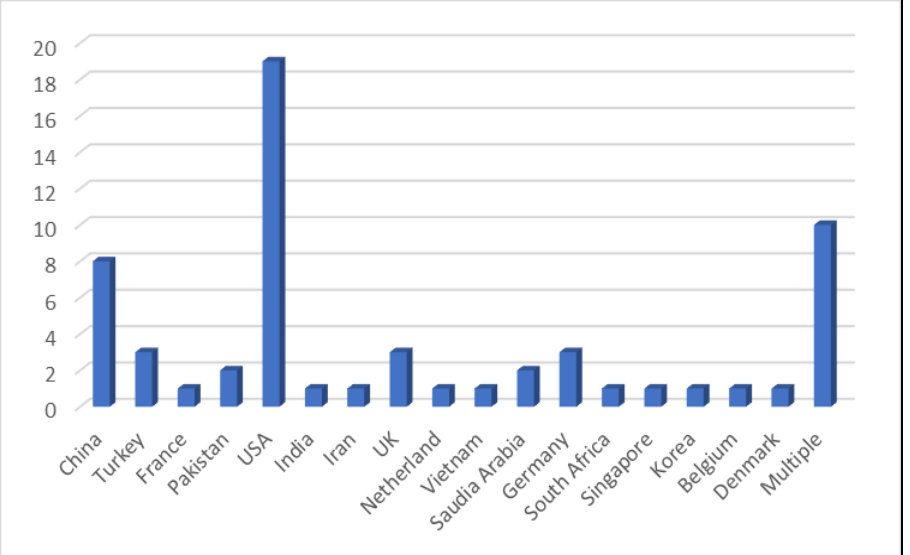
Figure.5.Country-Wise Trend of Publication on Investors’ Biases & Stock Return Volatility Source: Author’s own